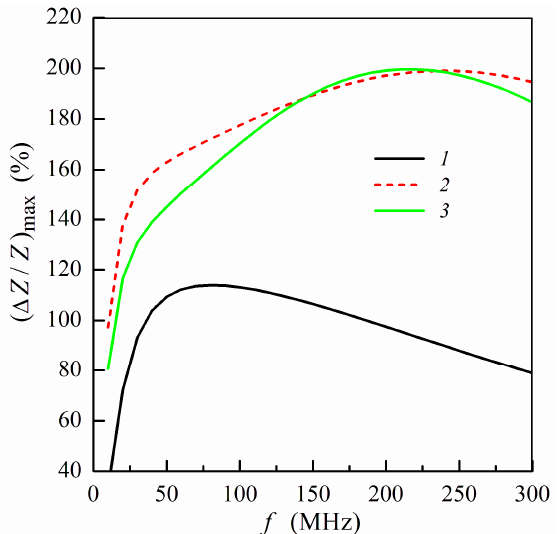
Figure 3. Frequency dependence of maximum MI ratio ( ∆ Z / Z ) max : curve 1, multilayered film without gel; curve 2, multilayer with pure gel (hydrogel) placed onto the surface of thin layer ( m = 3, n = 4); curve 3, multilayer with pure gel placed onto the surface of thick layer ( m = 4, n = 3) (see also Figure 1e,f). Other parameters used for calculations are the same as in Figure 2.